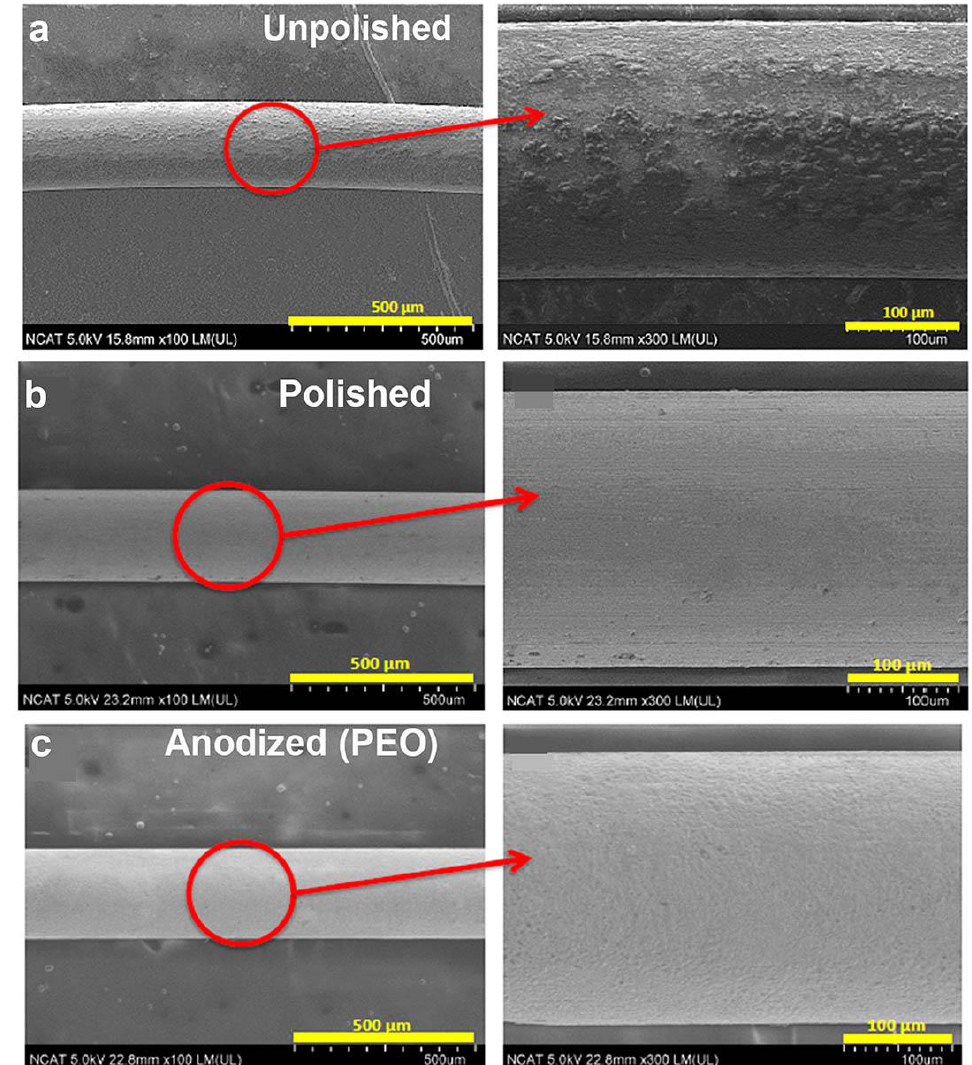
Figure 2. SEM imaging of ( a ) unpolished, ( b ) polished, and ( c ) PEO-anodized Mg filaments. With copyright permission from [35].